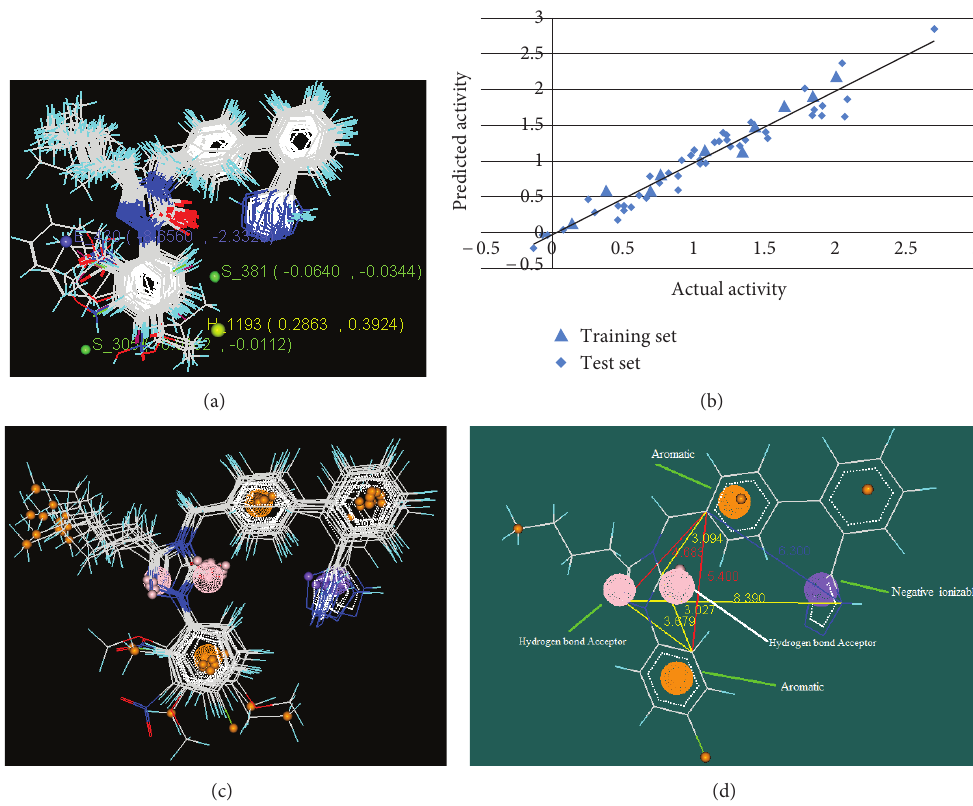
F 3: (a) Stereoview of the best SA-MLR corresponding to 3D model. (b) Graph of Actual and predicted activities of the training and test set 3D model